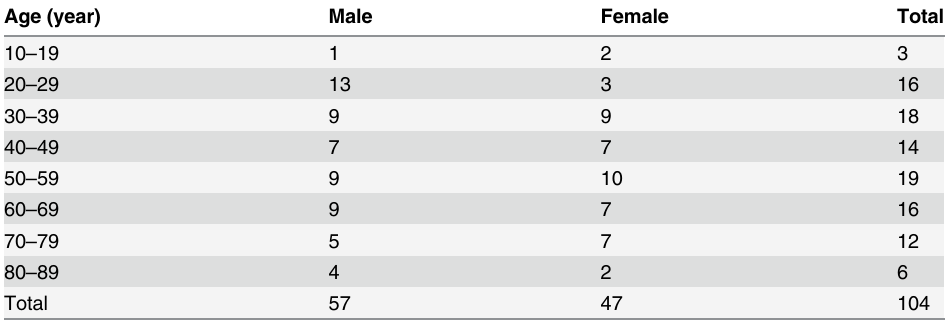
Table 1. Age and